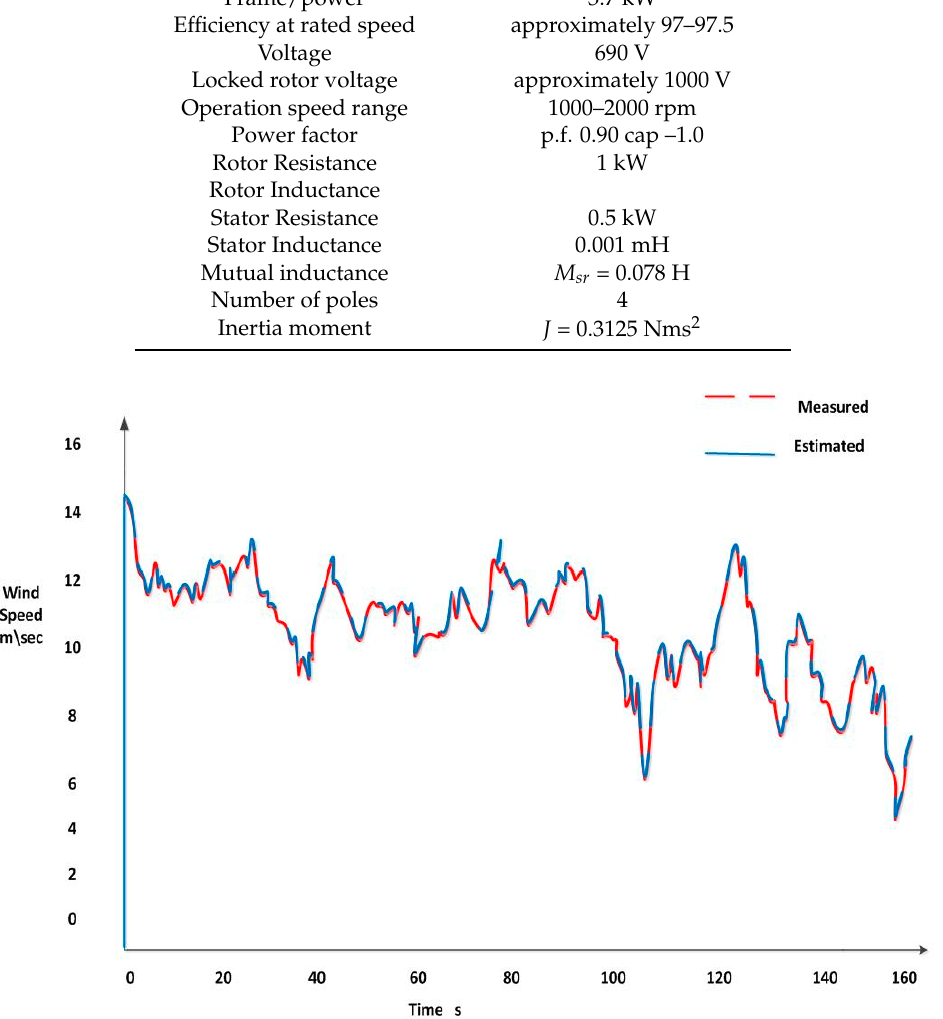
Figure 8. The wind speed estimated curve.